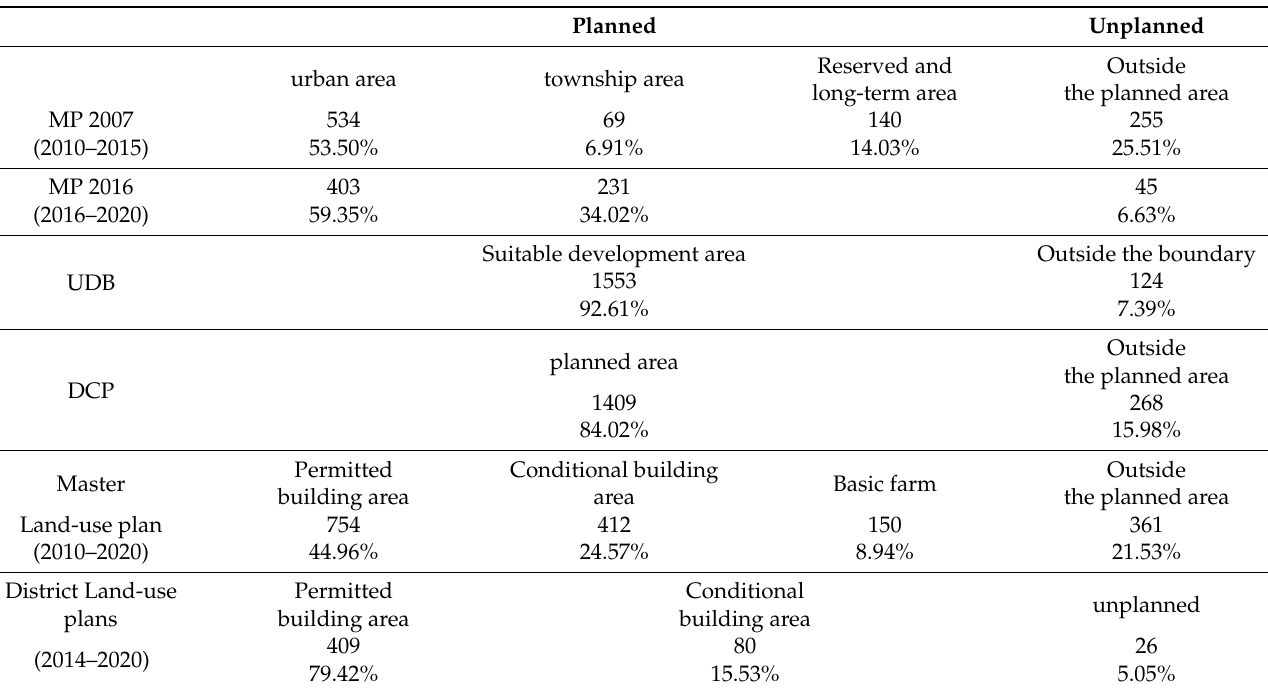
Table 2. Conformance between the urban planning and projects on administratively allocated land.